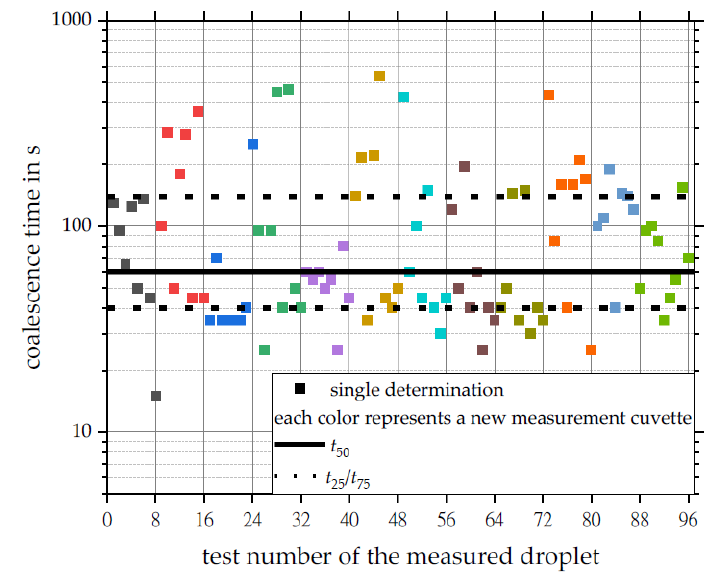
Figure 2. Repetitive measurements of single droplets with 0.1 wt% PGPH in the oil phase. Each color represents a new measurement cuvette. In each cuvette, eight droplets where measured